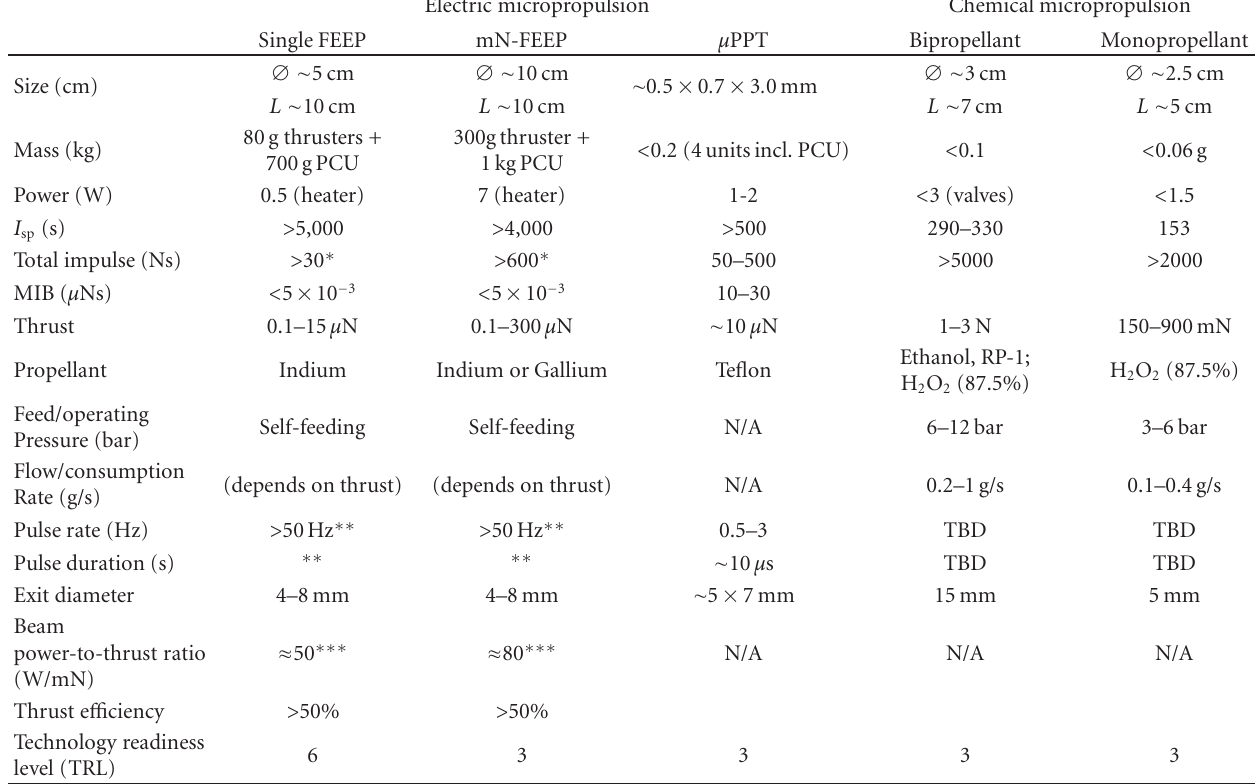
Table 2: Summary of micropropulsion key performance